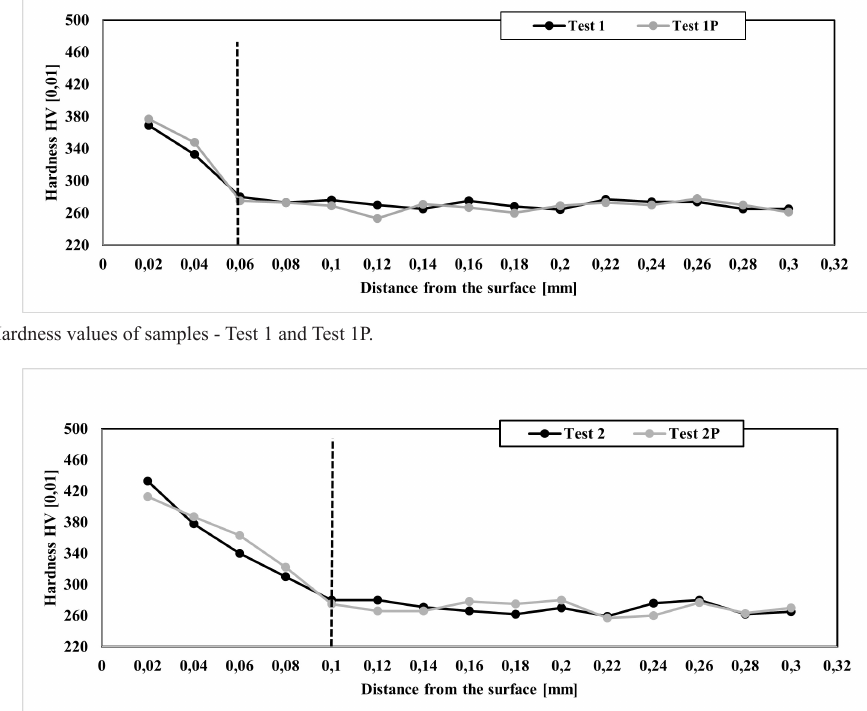
Figure 5 . Hardness values of samples - Test 2 and Test